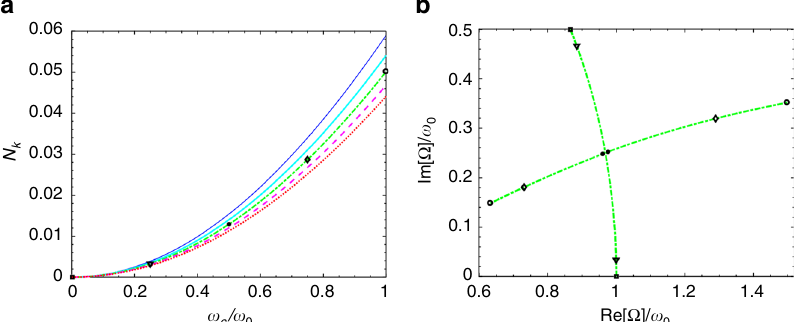
Fig. 2 Virtual photons in the resonant Lorentz model. a Number of photons in the resonant mode ck = ω 0 as a function of the coupling for γ L = 0 (thin blue line), 0.5 ω 0 (solid cyan line), ω 0 (dash-dotted green line), 1.5 ω 0 (dashed magenta line) and 2 ω 0 (dotted red line), that is the maximal physical value for the model we are considering. We see that going from the undamped to the overdamped regime, the number of virtual photons only diminishes of roughly the 25%. b Trajectory drawn by the eigenfrequencies in the complex plane, for ck = ω 0 and γ L = ω 0 , while varying ω c . The black symbols in a , b correspond to the same values of ω c . No visible discontinuity is present in the virtual photon population passing from the weak to the strong coupling